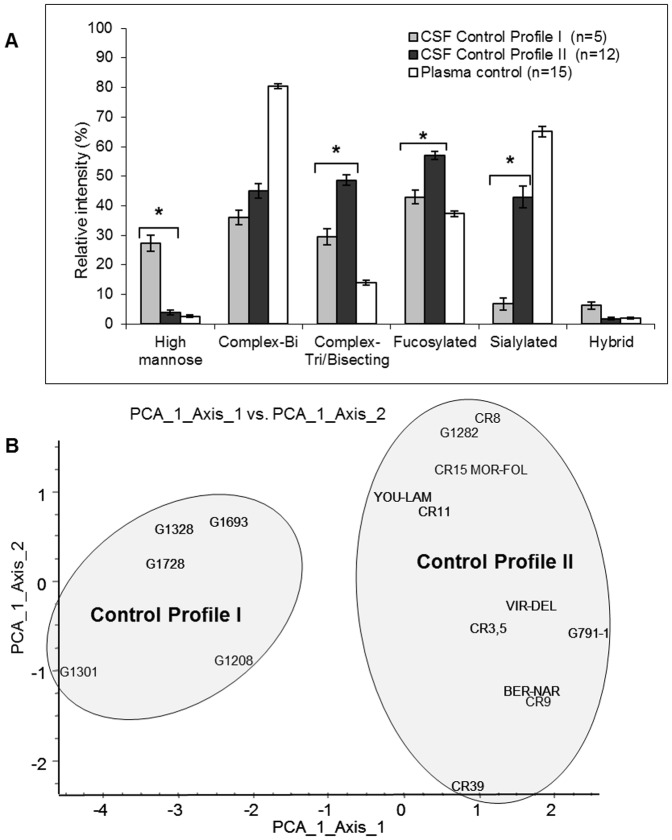
Two distinct N-glycan profiles exist in control CSF and are different to N-glycan profiles from plasma.
A) Comparison in the relative intensities (%, +/−SEM) of N-glycan types from control plasma and control CSF. B) Principal component analysis illustrating the differences between control CSF profiles leading to the distinction of two profiles named profile I and profile II. * Statistically significant with ANOVA test p values<0.005.